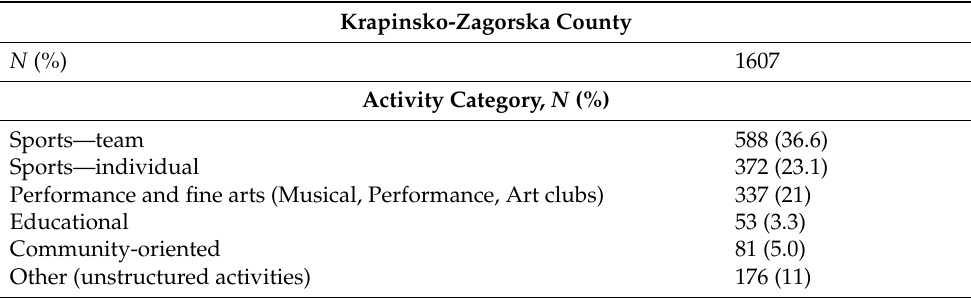
Table 1. Number of students reporting their current participation in SLA ( N =